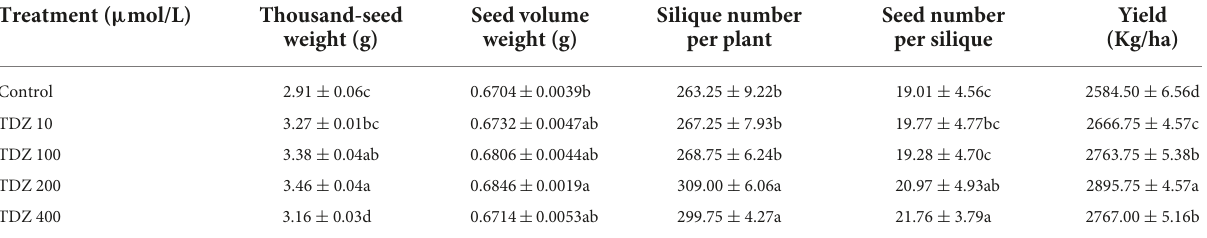
TABLE 1 Effect of TDZ treatments on seed yield-related traits.